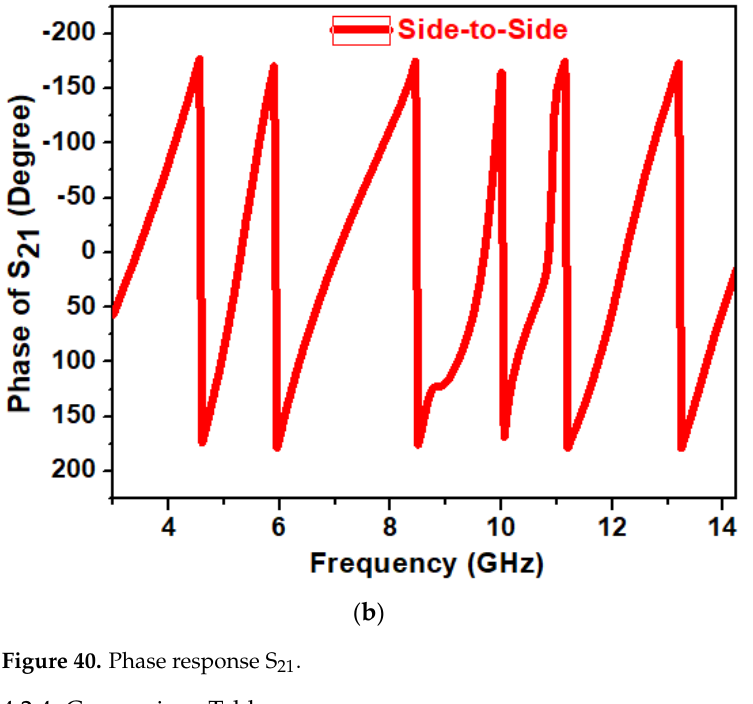
Figure 40. Phase response S 21.